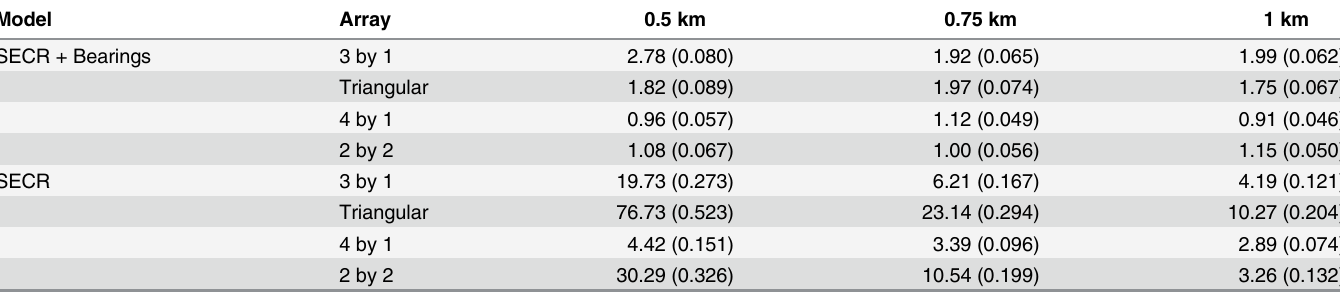
Table 2. Results of the first simulation study. Percentage bias and root mean squared error (in brackets) are given for density estimates.